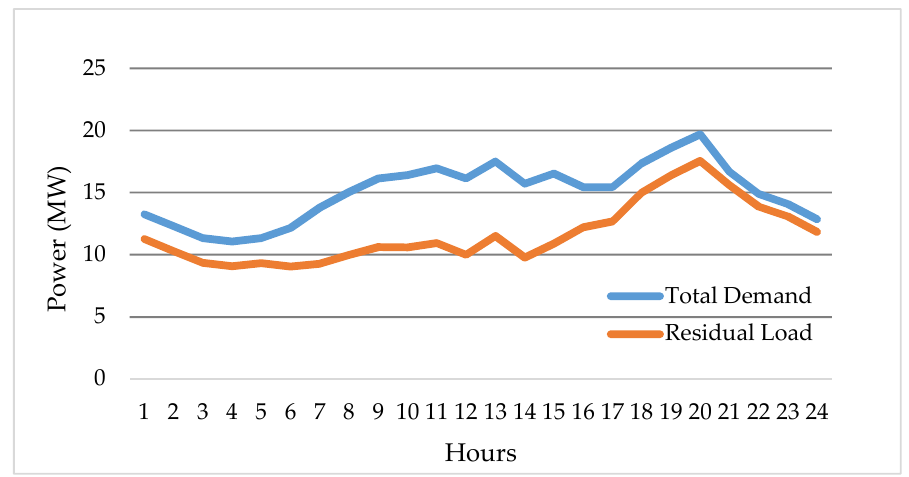
Figure 13. Residual load curve vs. load curve in 2019 for an example day. Source: own elaboration with the model [27].